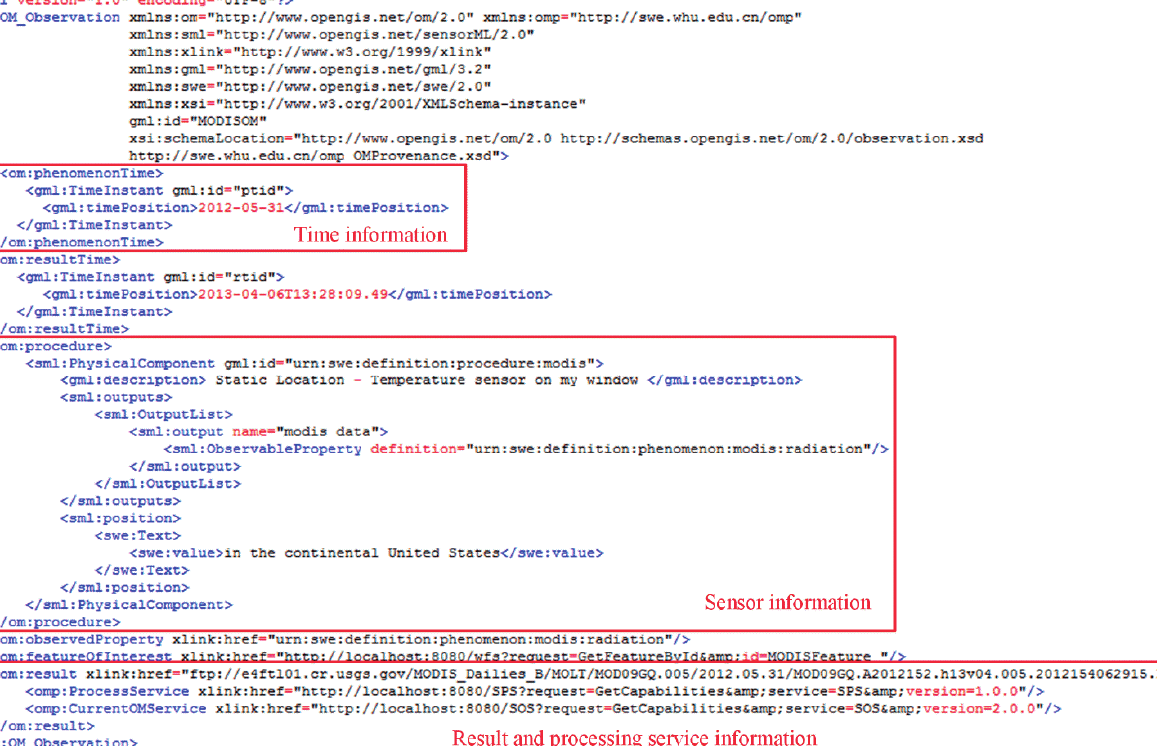
Figure 9. Original tile HDF